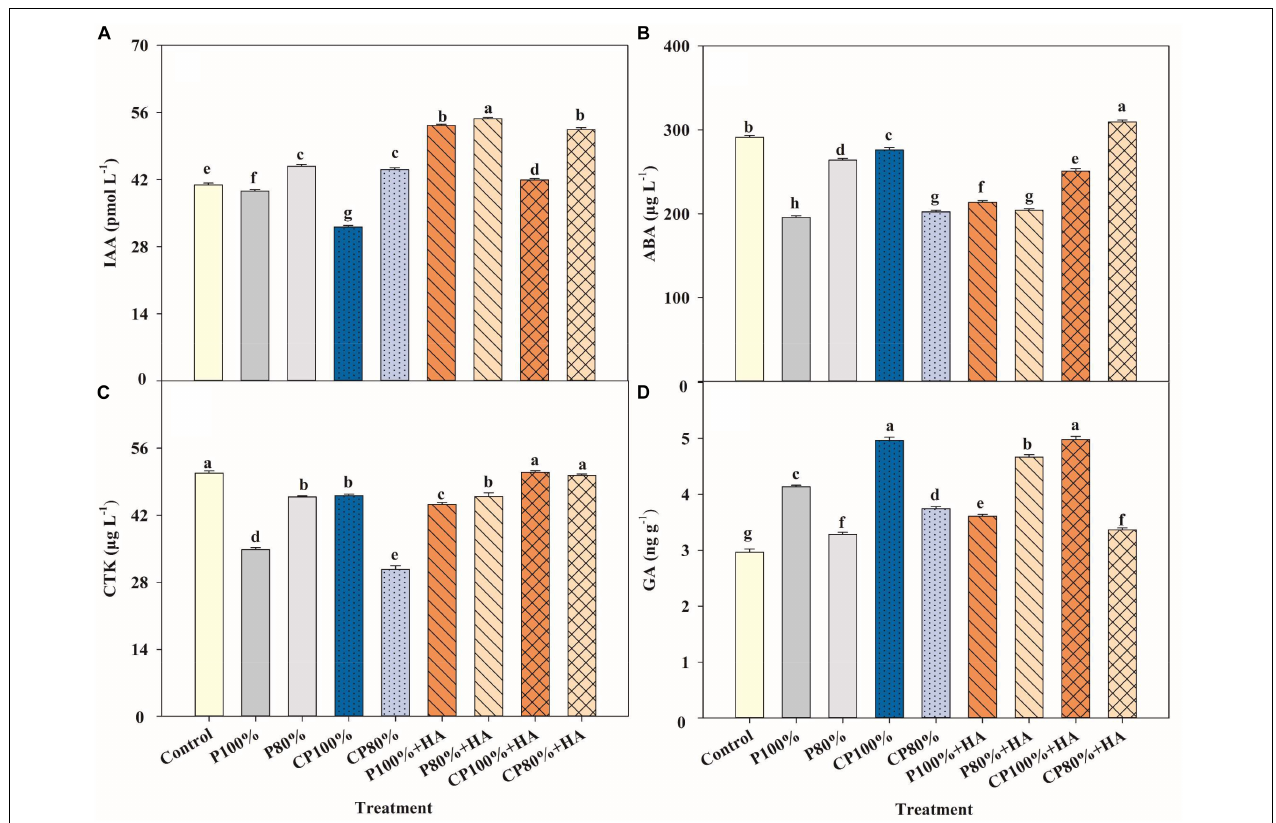
FIGURE 7 | Auxin indole-3-acetic acid (IAA) (A) , abscisic acid (ABA) (B) , cytokinin (CTK) (C) and gibberellin GA (D) contents of maize leaves in different fertilization treatments at the twelve-leaf stage. Control, no P fertilizer added; P 100%, diammonium phosphate (DAP) at 75 kg P 2 O 5 ha − 1 ; P80%, DAP at 60 kg P 2 O 5 ha − 1 ; CP 100%, coated DAP (CDAP) at 75 kg P 2 O 5 ha − 1 ; CP8 0%, CDAP at 60 kg P 2 O 5 ha − 1 ; P 100% + HA, DAP at 75 kg P 2 O 5 ha − 1 and combined with humic acid (HA); P 80% + HA, DAP at 60 kg P 2 O 5 ha − 1 and combined with HA; CP 100% + HA, CDAP at 75 kg P 2 O 5 ha − 1 and combined with HA; CP 80% + HA, CDAP at 60 kg P 2 O 5 ha − 1 and combined with HA. Different letters above the bars indicate significant differences at P < 0.05 followed by Duncan’s multiple range